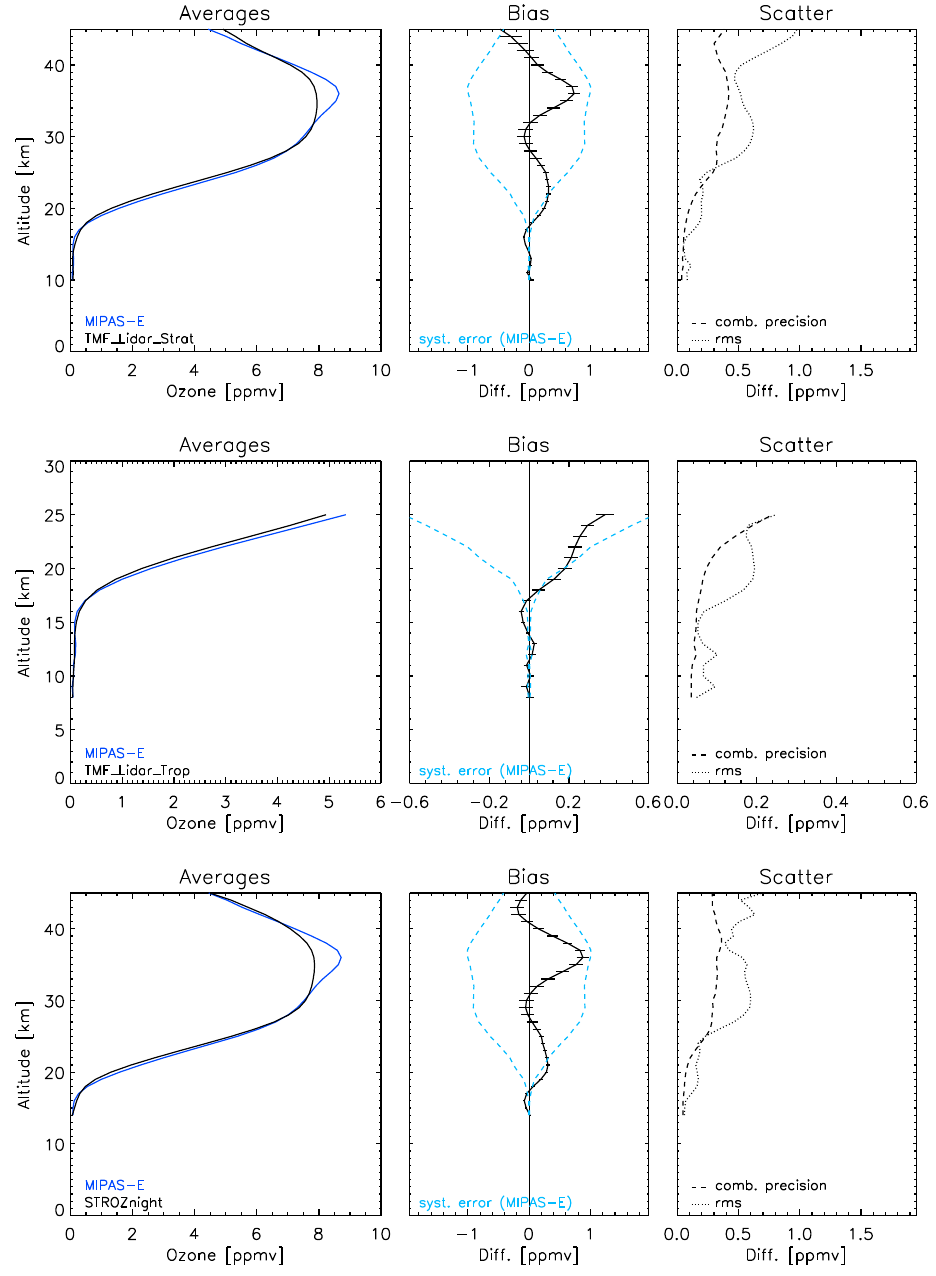
Fig. 16. Same as Fig. 2, but for the stratospheric TMF lidar ozone profiles (nightly means) (top row), the tropospheric TMF lidar ozone profiles (nightly means) (middle row), and STROZ ozone profiles (nightly means) (bottom row). For a more detailed description see Fig. 2. and all other instruments, together with their standard errors, are compiled in Fig. 19, top